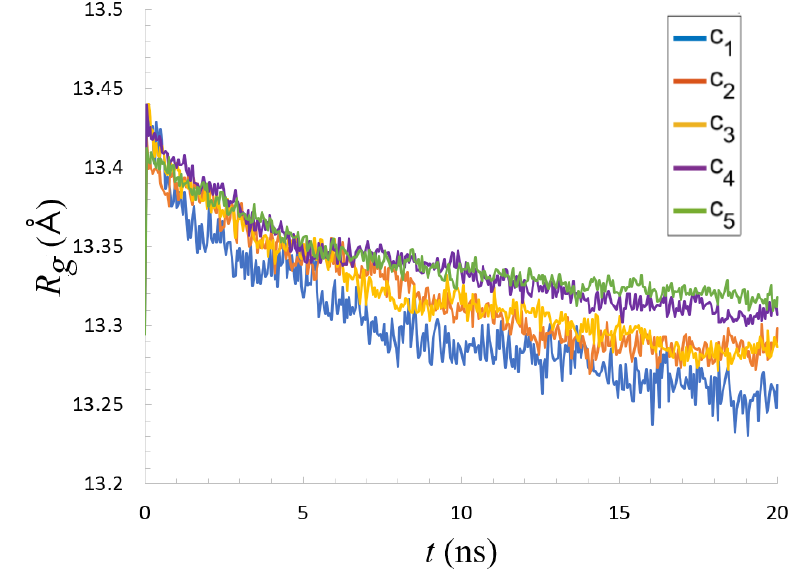
Figure 3. Radius of gyration (averaged over all molecules originating across all simulation runs) as a function of